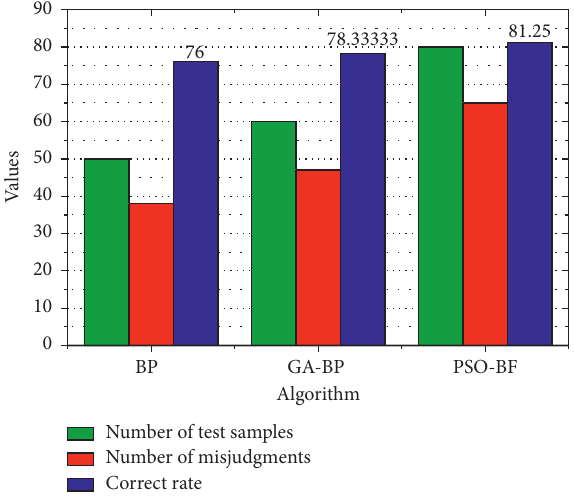
Figure 4: Comparison of prediction results of BP model, GA-BP model, and PSO-BP